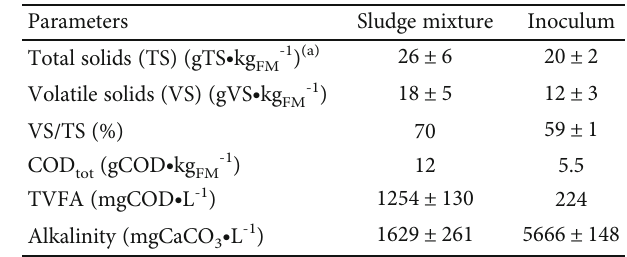
Table 2: Chemical characterization ( mean ± standard deviation ) of inoculum and sludge mixture /CO ratio adopted. 2 2